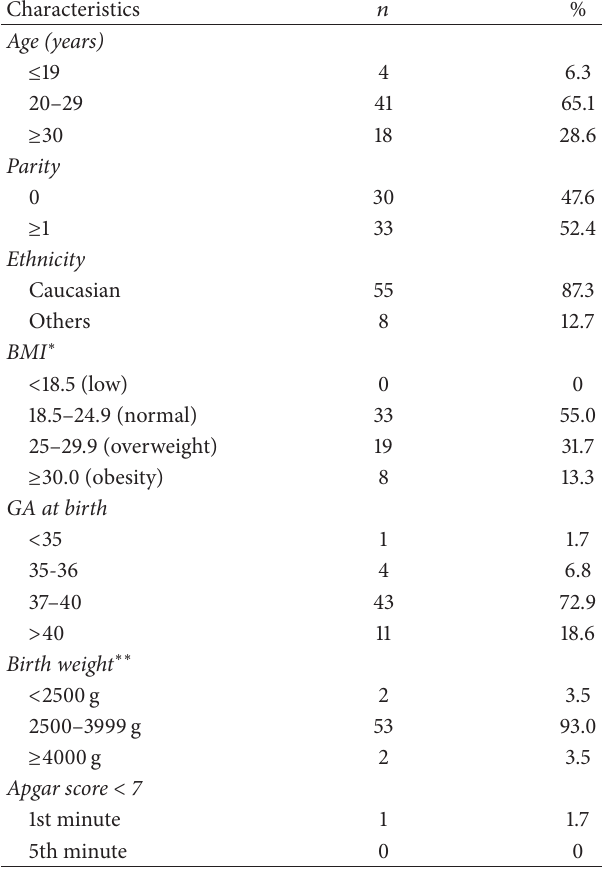
Table 1: Sociodemographic characteristics, parity, and neonatal outcomes of women included in the